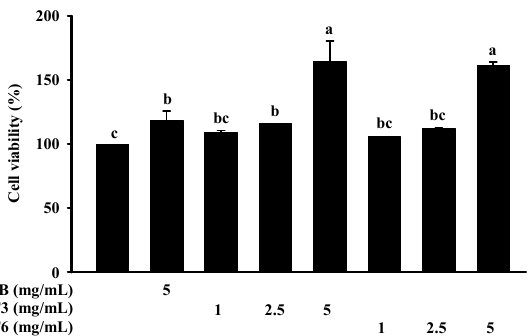
Figure 2. Effect of FB, F3, and F6 on cell viability in Clone-9 cells. Data are expressed as mean ± SD ( n = 3). Tukey’s tests were performed, with similar superscripts among each group (a,b,c) indicating non-significant difference ( p < 0.05). FB: fish bone; F3: fish bone fermented with Monascus purpureus for 3 days; F6: fish bone fermented with Monascus purpureus for 6 days.